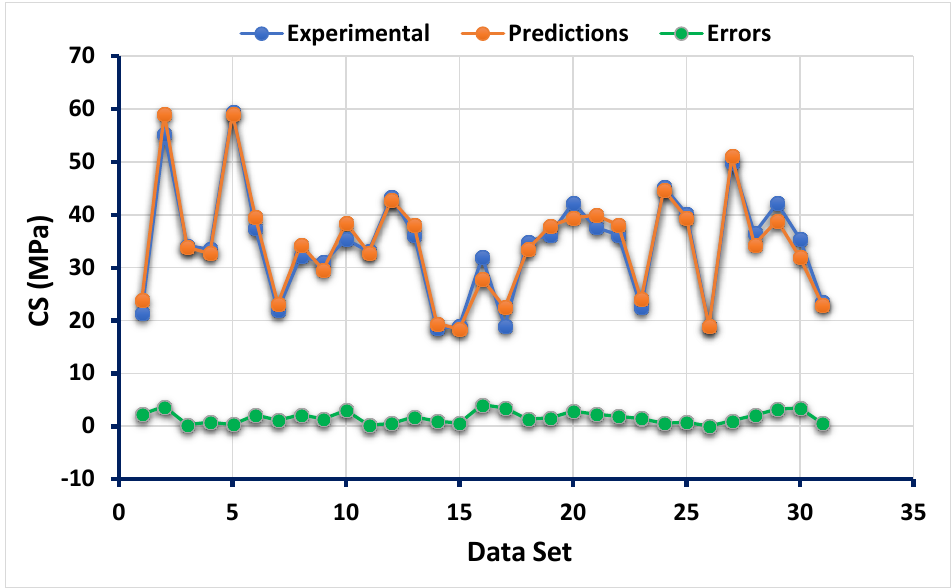
Figure 5. Error distribution of the targeted and predicted results from boosting approach.